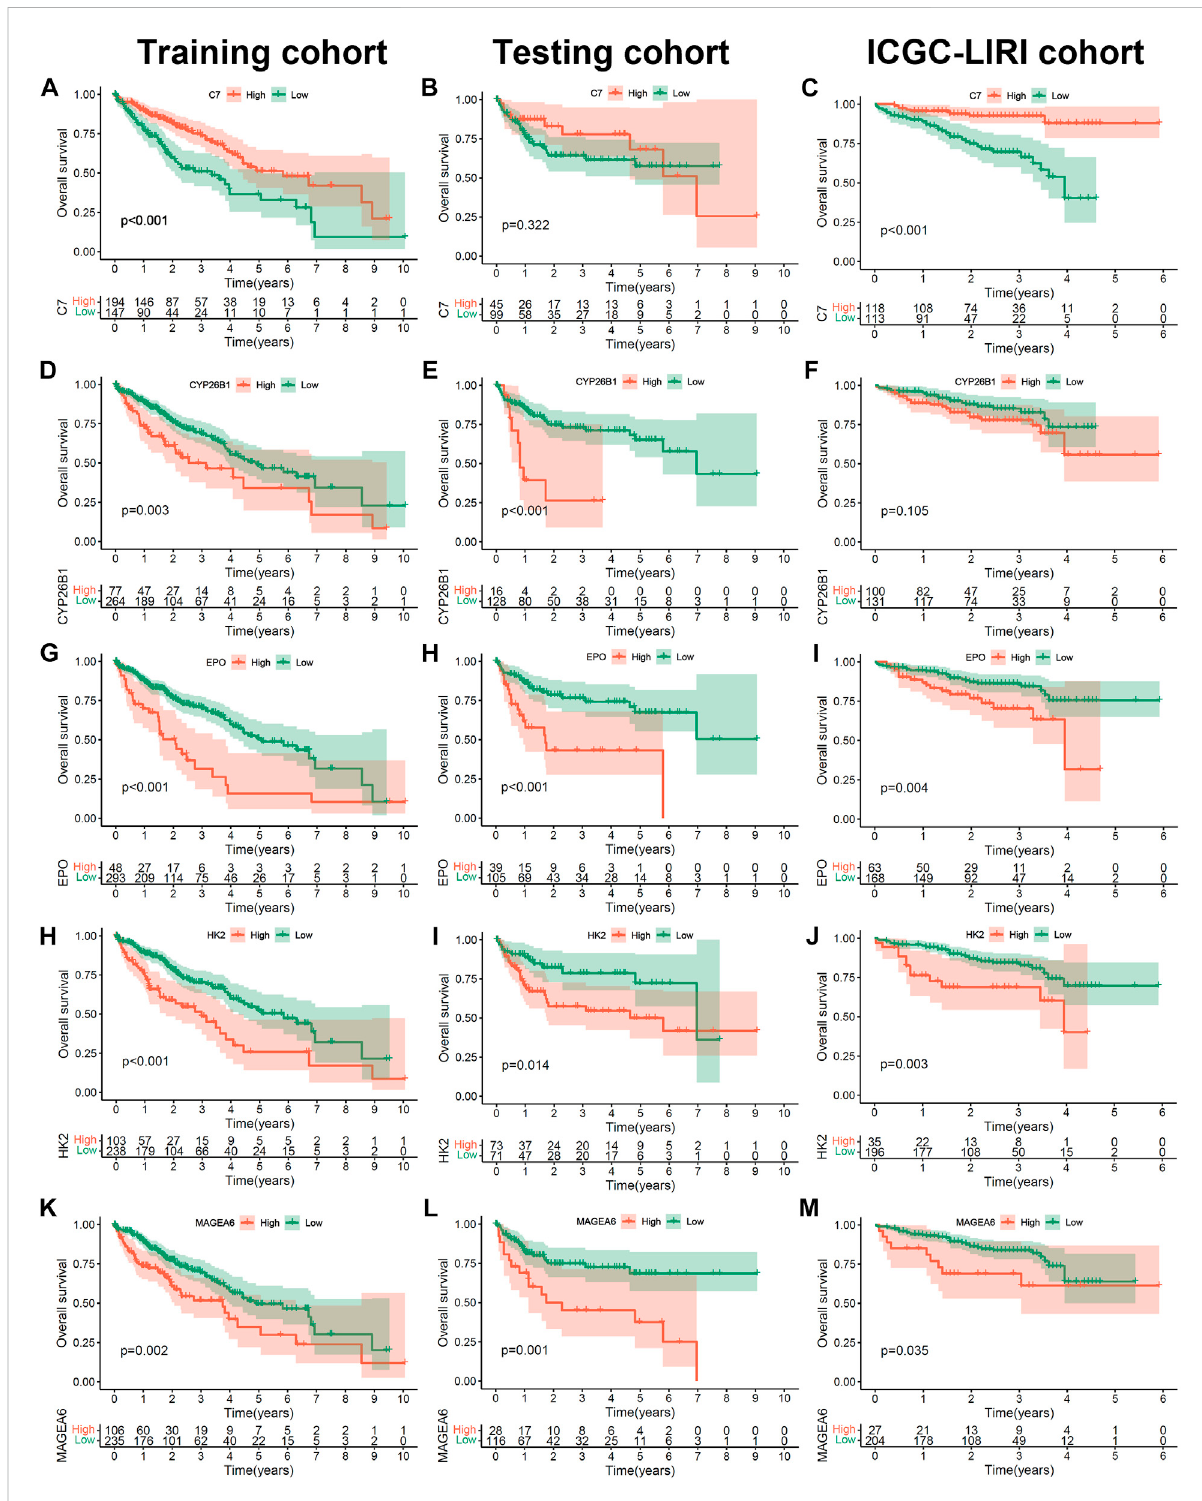
FIGURE 5 The prognosis value of 5 hub Cu-DEGs in three HCC cohorts. (A – M) The Kaplan-Meier curves of C7 in training (A) , testing (B) and ICGC (C) cohorts, as well as CYP26B1 (D – F) , EPO (G – I) , HK2 (H – J) and MAGEA6 (K – M)